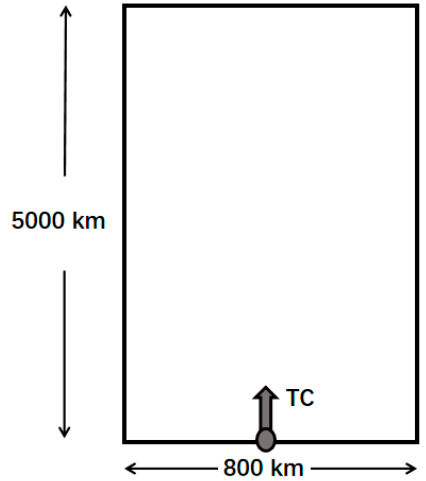
Figure 1. Simulation domain and initiation of the TC.